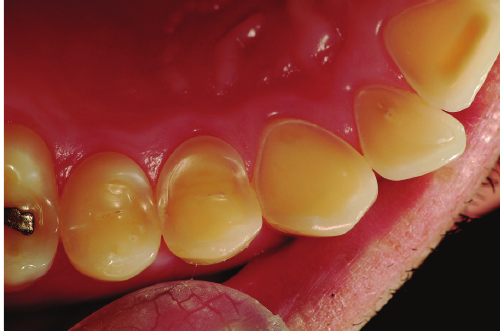
Figure 3: Occlusal view of maxillary teeth with worn surfaces.